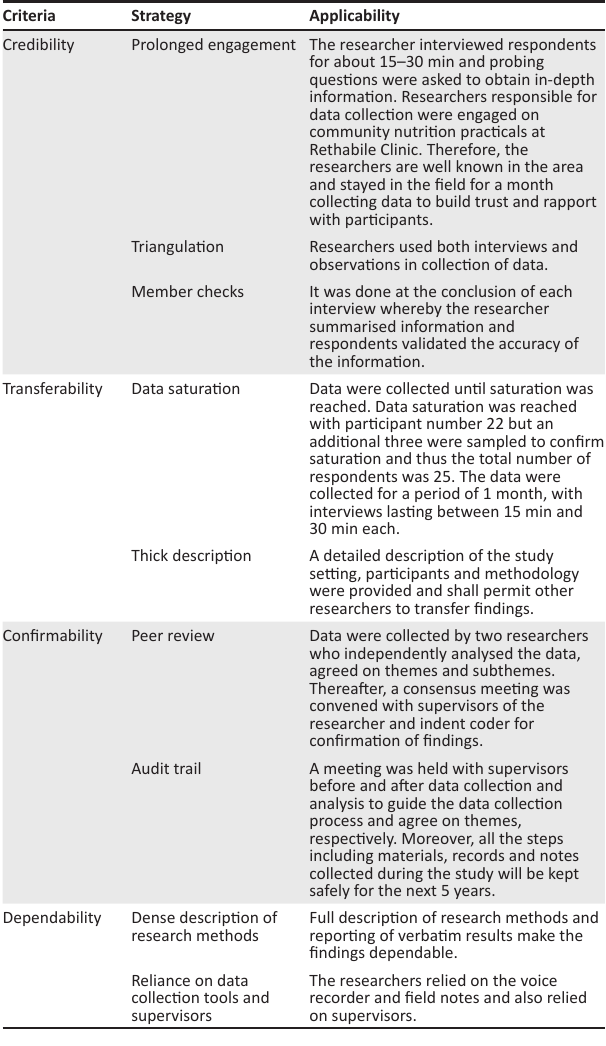
TABLE 1: Measures to ensure